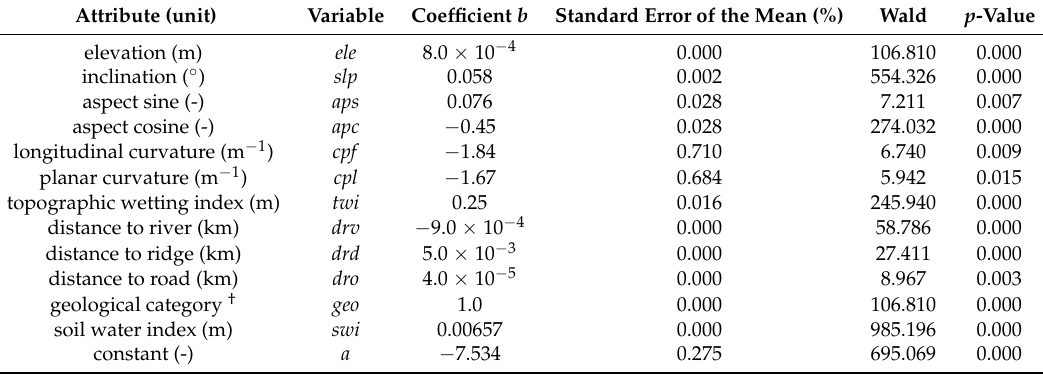
Figure 4. Predicted landslide area using Equation (2) before and after recalibration in terms of the observed landslide inventory of the nine typhoons. Table 1. Logistic regression coefficients and the significance level of explanatory variables.